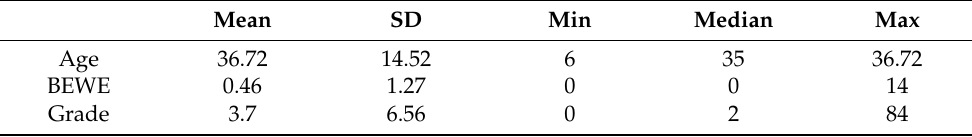
Table 5. Shows the statistical analysis results on age, BEWE index and degree of